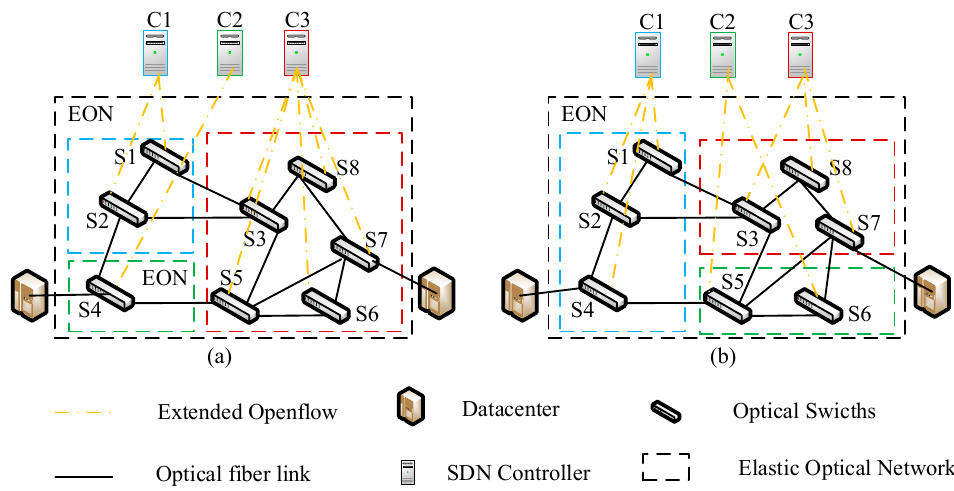
Figure 1. An example of the multi-controller deployment: ( a ) controller load imbalance; ( b ) con- load troller load balancing.